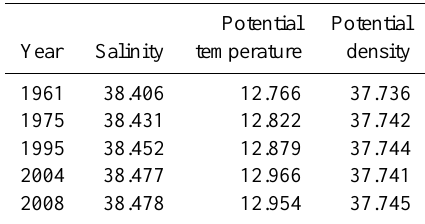
Table 1. Depth-average salinity, potential temperature and potential density referenced to 2000dbar below 200dbar for historical sta- tions in the western Mediterranean near the eastern entrance to the Alboran Sea. Potential density referenced to 2000dbar is defined as density – 1000 in units of kgm − 3 . The 1961 station is Atlantis station 6010 in Miller et al. (1970). The 1975 station is Chain sta- tion 79 in Bryden et al. (1978). The 1995 station is Meteor station 2 from Roether et al. (1996). The 2004 and 2008 stations are Urania stations made as part of CNR repeat surveys of the western Mediter- ranean Sea (Schroeder et al., 2010). CTD station data have a preci- sion in salinity of 0.003 and in temperature of 0.001 ◦ C, while the older Atlantis discrete bottle data have a precision in salinity of 0.01 and in temperature of 0.003 ◦ C. Differences in expedition method- ologies and instrumentation lead to possible biases in salinity and temperature of 0.01 and 0.005 ◦ C between expeditions. Potential Potential Year Salinity temperature density 1961